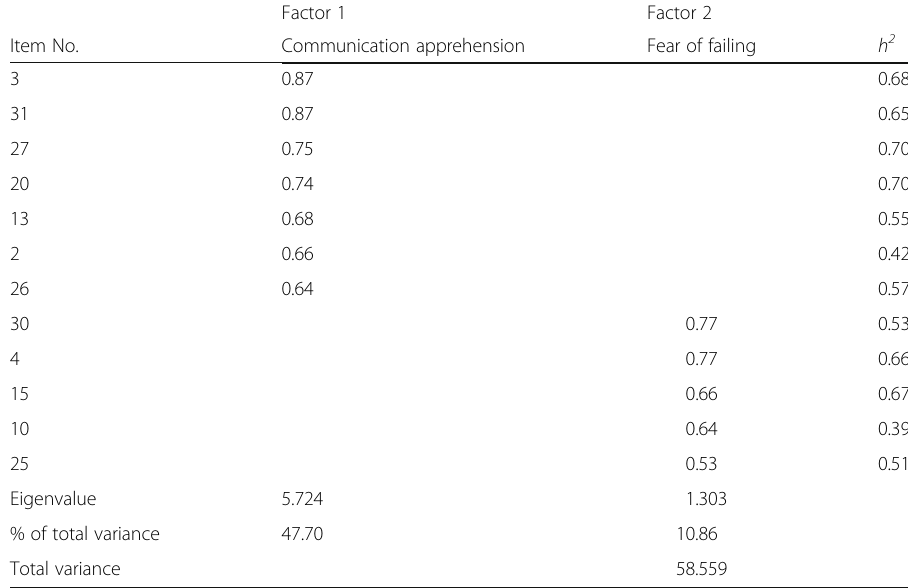
Table 6 Results of the fourth exploratory factor analysis of the FLCAS with direct oblimin rotation ( n = 149) Factor 1 Factor 2 Item No.